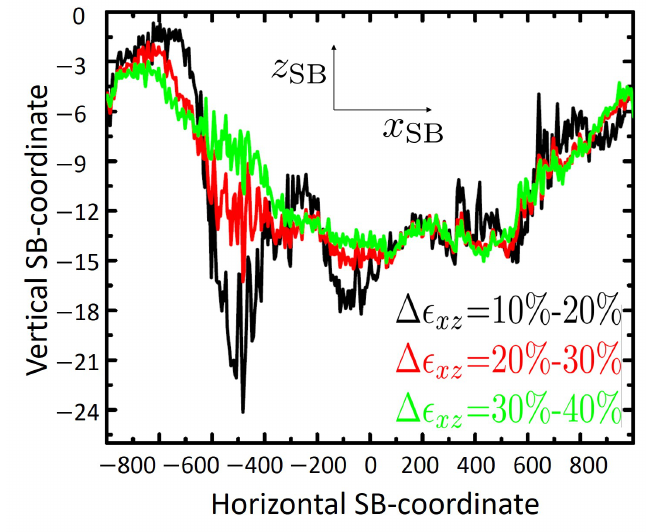
Figure 2. Average vertical coordinate of shear band, z SB , versus lateral position, x SB , evaluated for three different shear strain intervals as indicated. Each pair of x SB and z SB numbers is obtained as geometric center of particles within a slab of thickness ∆ x = 5 which belong to the shear band. Each curve shown here represents an average over ten calculations, performed for small strain intervals of [ (cid:101) xz , (cid:101) xz + 1% ] , [ (cid:101) xz + 1%, (cid:101) xz + 2% ] , ..., [ (cid:101) xz + 9%, (cid:101) xz + 10% ] with (cid:101) xz = 10%, 20% and 30%,